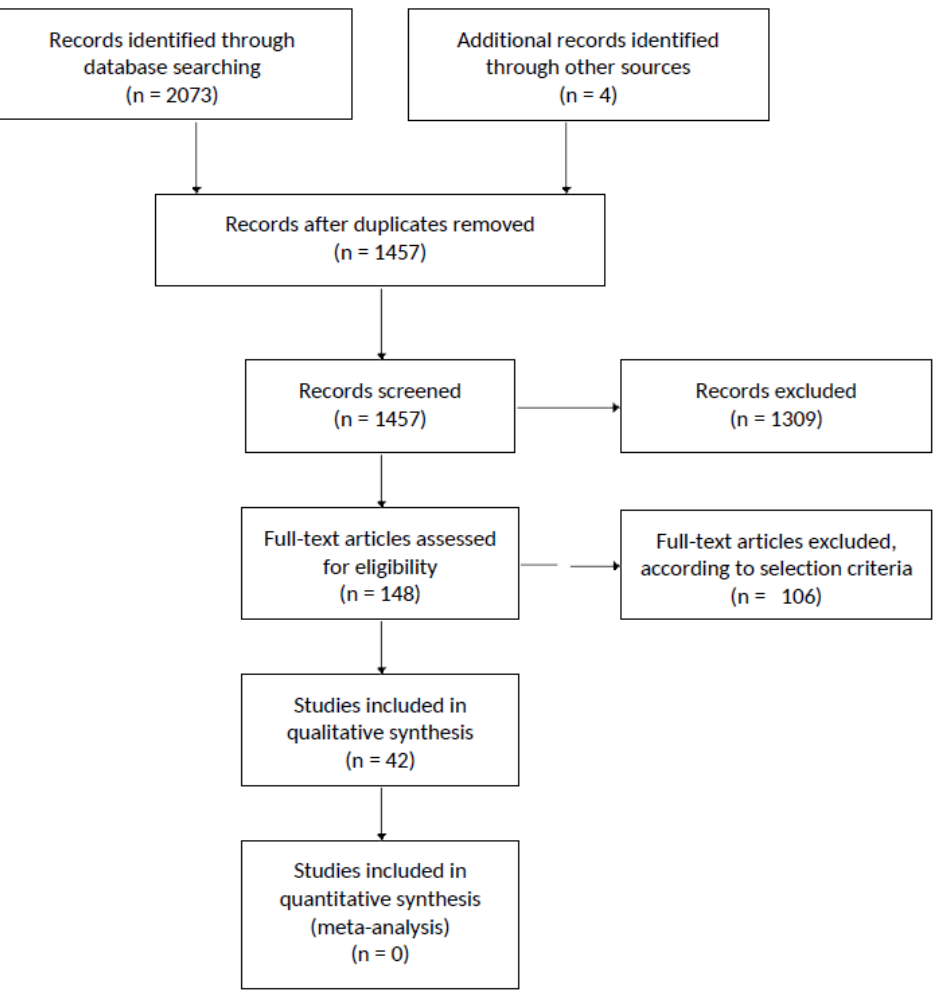
Figure 1. Prisma Flowchart of Review Results.